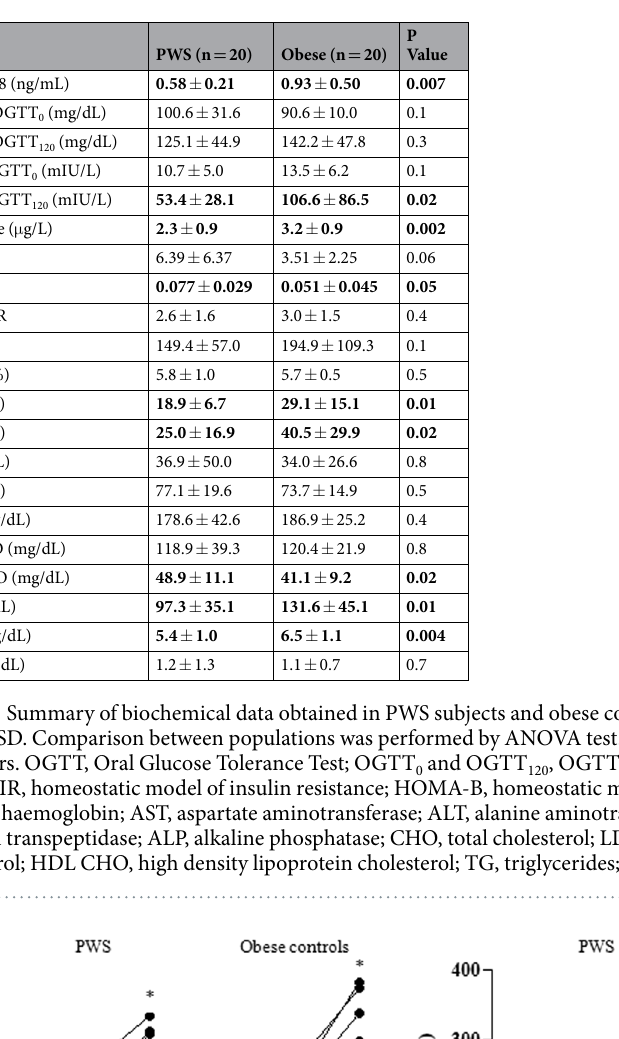
by repeated measures ANOVA) (Fig. 3), and by association observed between ANGPTL8 levels and liver stea- tosis in the group of obese controls (r = 0.53, p < 0.05). Of note, a significant association was also seen between ANGPTL8 levels and REE (r = 0.32, p = 0.05) as well as FFM (r = 0.31, p < 0.05), while only in PWS ANGPTL8 levels were inversely associated with %FM (r = − 0.46, p < 0.05). Significant correlations obtained on the entire dataset were lost after controlling for PWS status, thereby confirming the blunting effect of PWS on ANGPTL8 levels (r = − 0.42, p < 0.01). There were no differences in ANGPTL8 levels and liver steatosis when PWS group was analysed according to GH treatment or genotype (data not shown). Stepwise multivariable regression analysis documented that ANGPTL8 levels were negatively predicted by PWS status (standardized β = − 0.41, p = 0.01). After the removal of PWS status from the regression equation, ALT levels (standardized β = 0.39, p = 0.01) or the score of liver steatosis (standardized β = 0.35, p < 0.05), acted as independent predictors of ANGPTL8 levels.